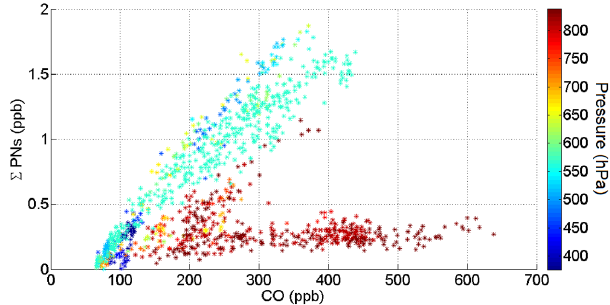
Figure 3. Scatter plot of the P PNs and the CO as function of the pressure of flight